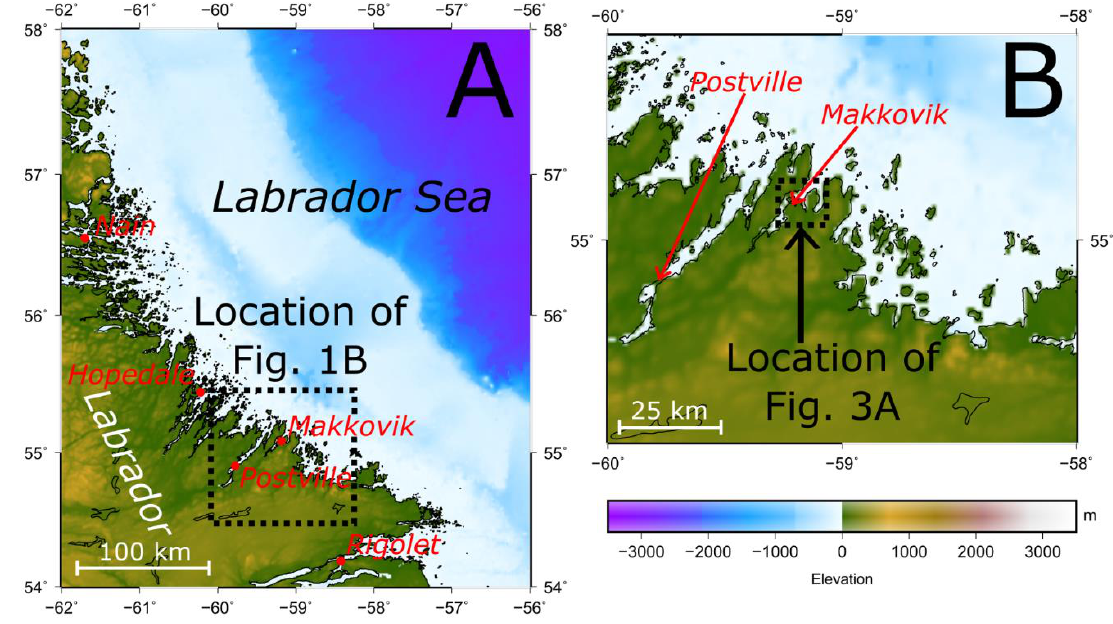
Figure 1. ( A ) The northeast coast of Labrador, Canada. ( B ) The area surrounding the study area shown